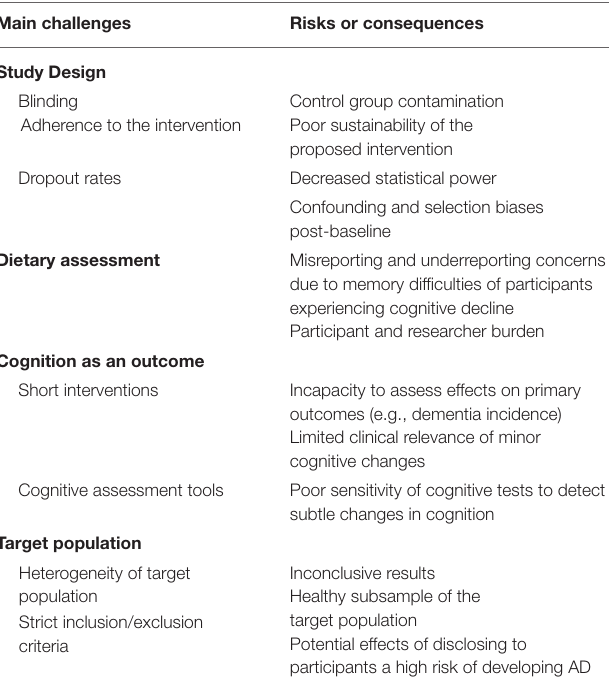
TABLE 3 | Challenges of traditional clinical trials testing the efficacy of nutritional interventions for dementia